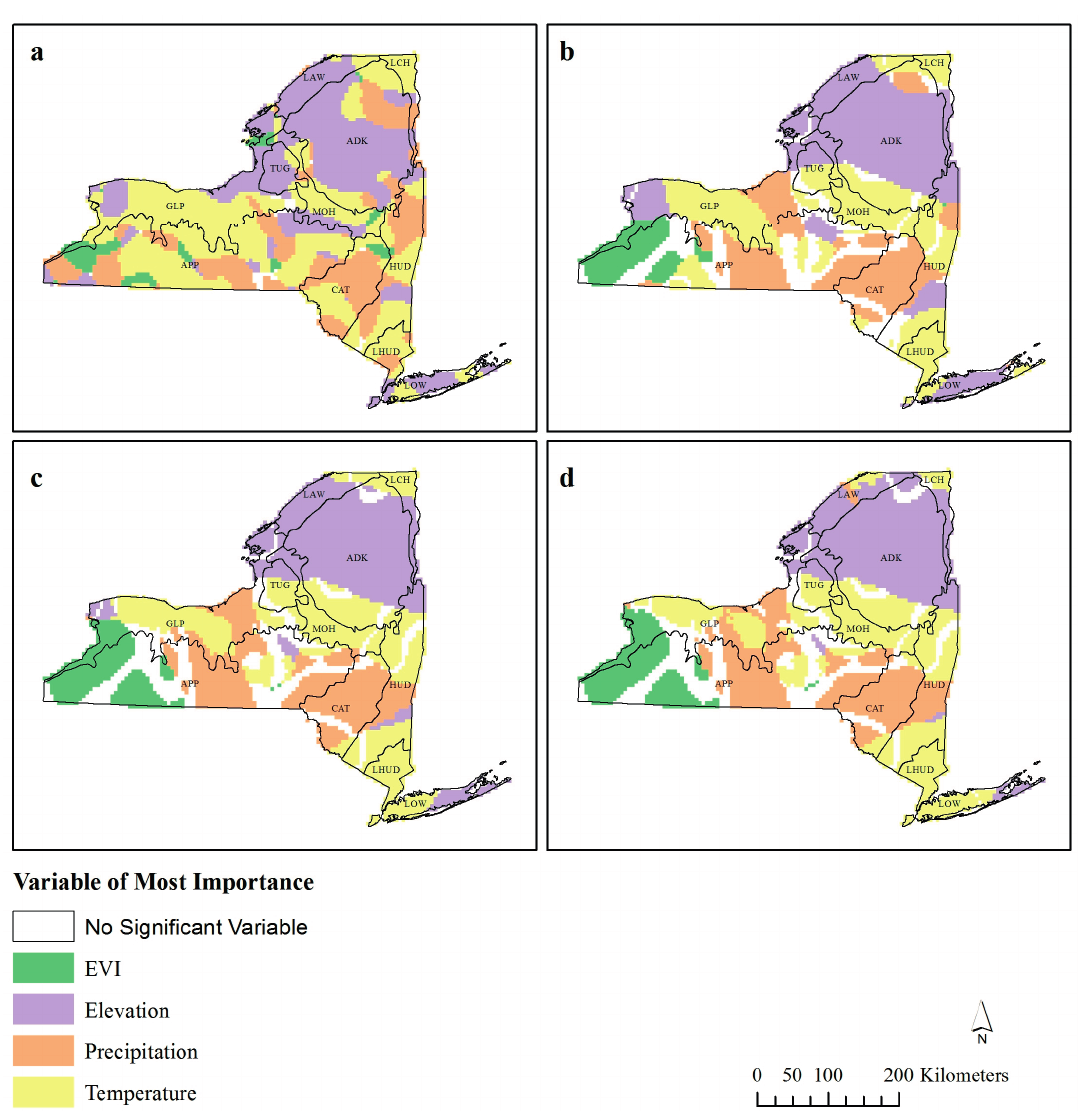
Figure 3. Standardized variable of most importance for geographically weighted regression (GWR) bandwidths ( a ) 30 km,( b ) 60 km, ( c ) 90 km, and ( d ) 120 km. Only variables with β > ±1.96 are